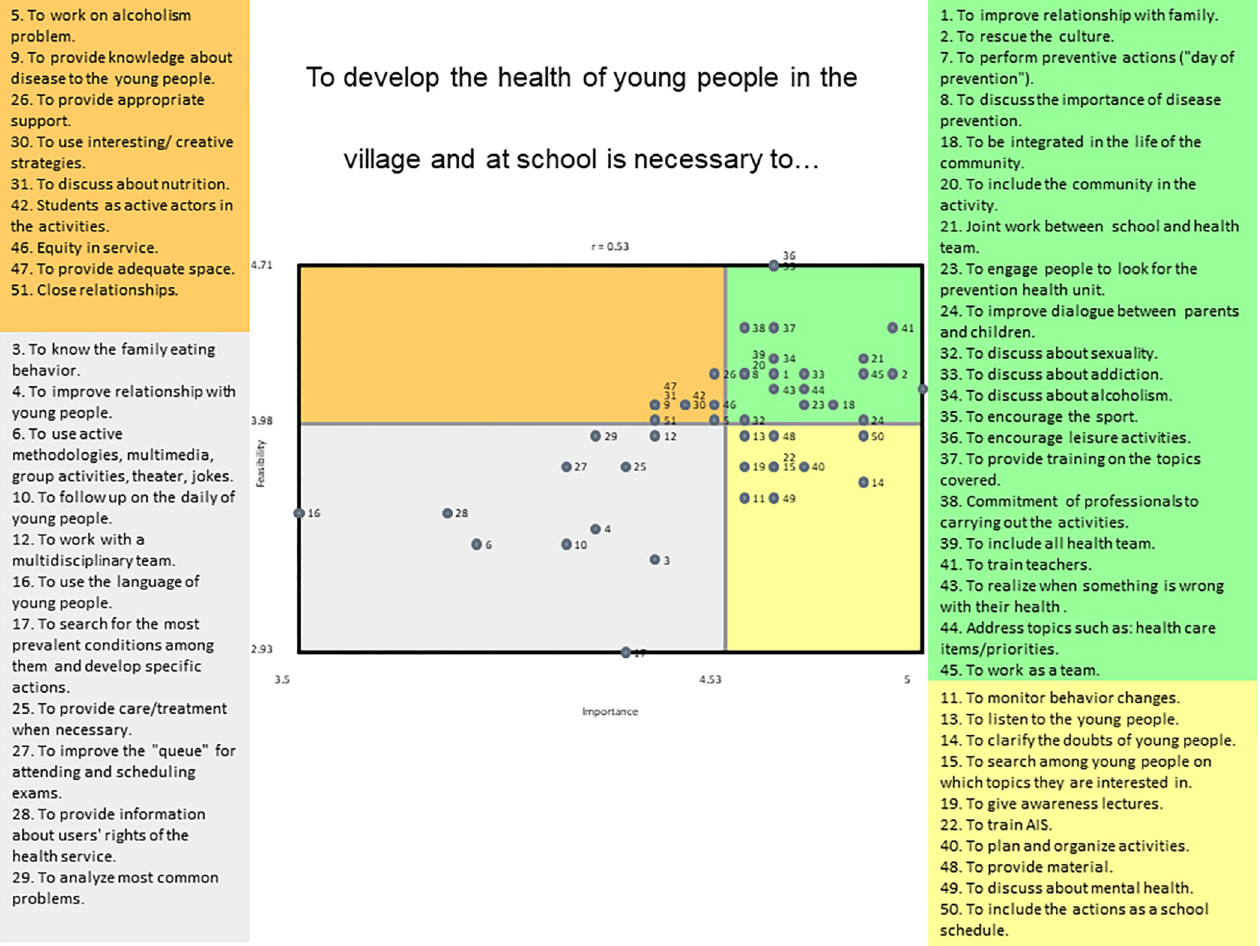
Fig 4. Adult Go-zone map based on their perspectives on important and feasible actions in response to the prompt ‘ To develop the health of young people in the village and at school is necessary to ... ’ Coloured circles indicate to what cluster each statement